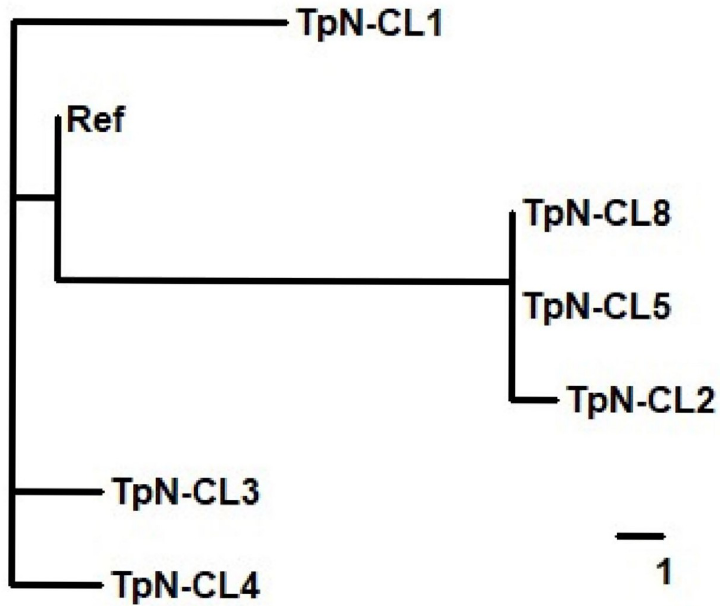
Fig 8. Cladogram showing the degree of genomic identity among the T . pallidum Nichols clones and the reference T . pallidum Nichols sequence NC_021490.2. The diagram is based on the 24 SNV and indel sites in Table 2 that have only two genotypes (e.g. T or C, or 1 or 2 repeat sequences); only TP0470 , which has a variable number of repeat sequences, and the VR differences observed in tprK are excluded. One difference is equivalent to the horizontal distance shown by the reference bar in the lower right corner. The results indicate the close overall sequence identity of TpN-CL2, TpN-CL5, and TpN-CL8, the relatedness of TpN-CL3 and TpN-CL4, and the relatively frequent sequence differences in TpN-CL1 as compared to the other clones.